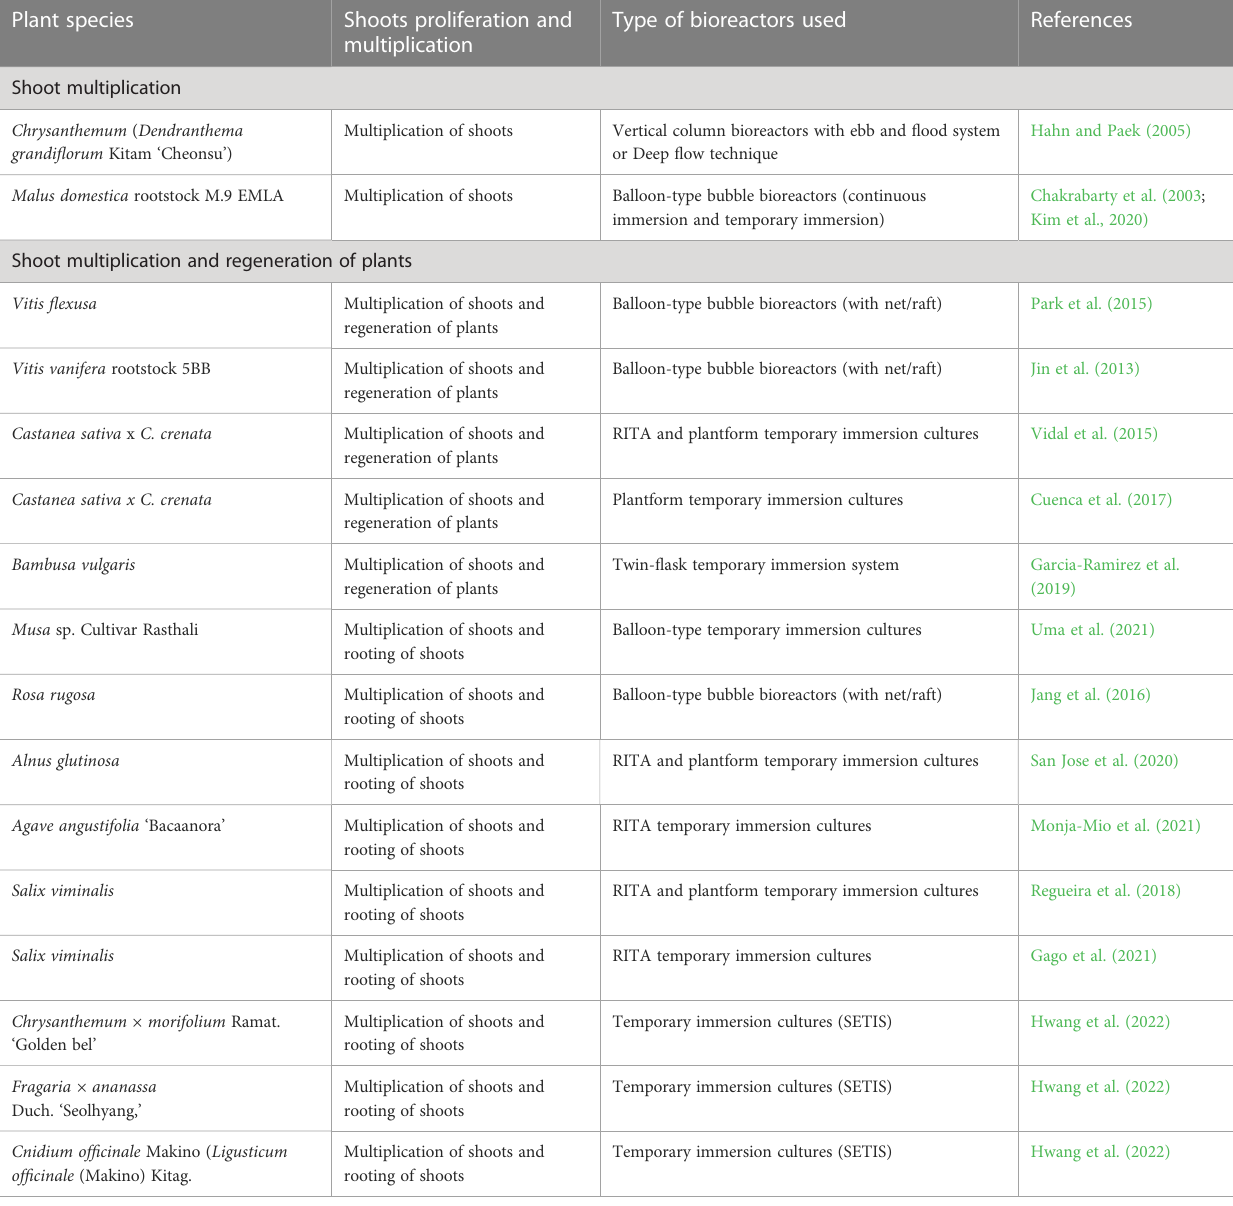
TABLE 3 Selected examples of shoot proliferation and multiplication in bioreactor